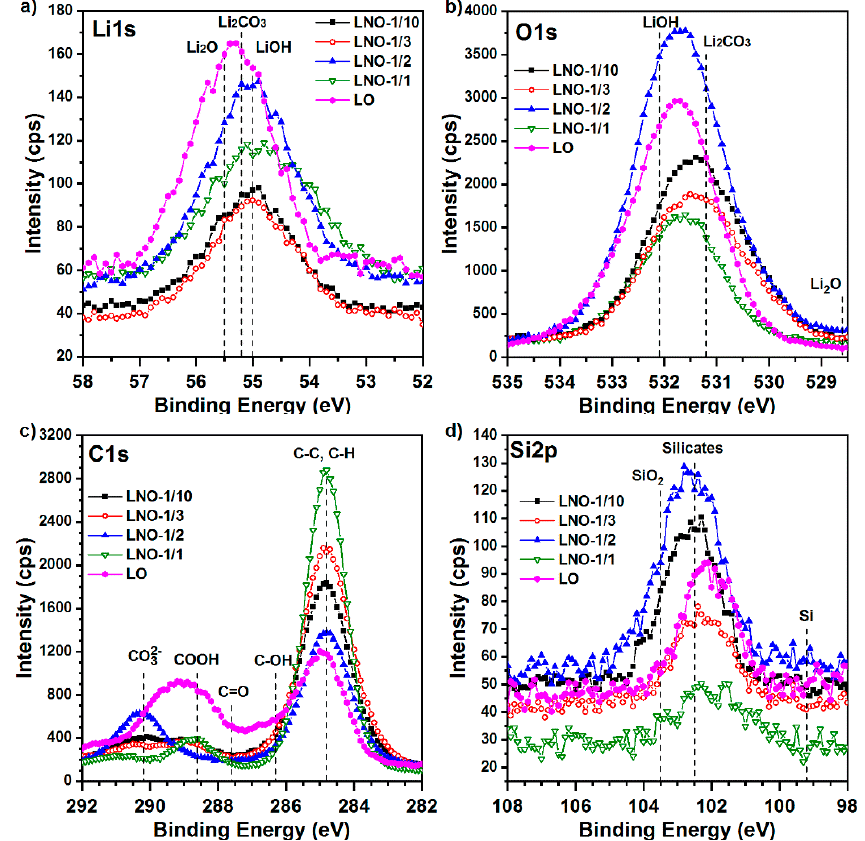
Figure 2. X-ray photoelectron (XPS) ( a ) Li1s, ( b ) O1s, ( c ) C1s, ( d ) Si2p spectra for LNO samples deposited on the stainless-steel supports.